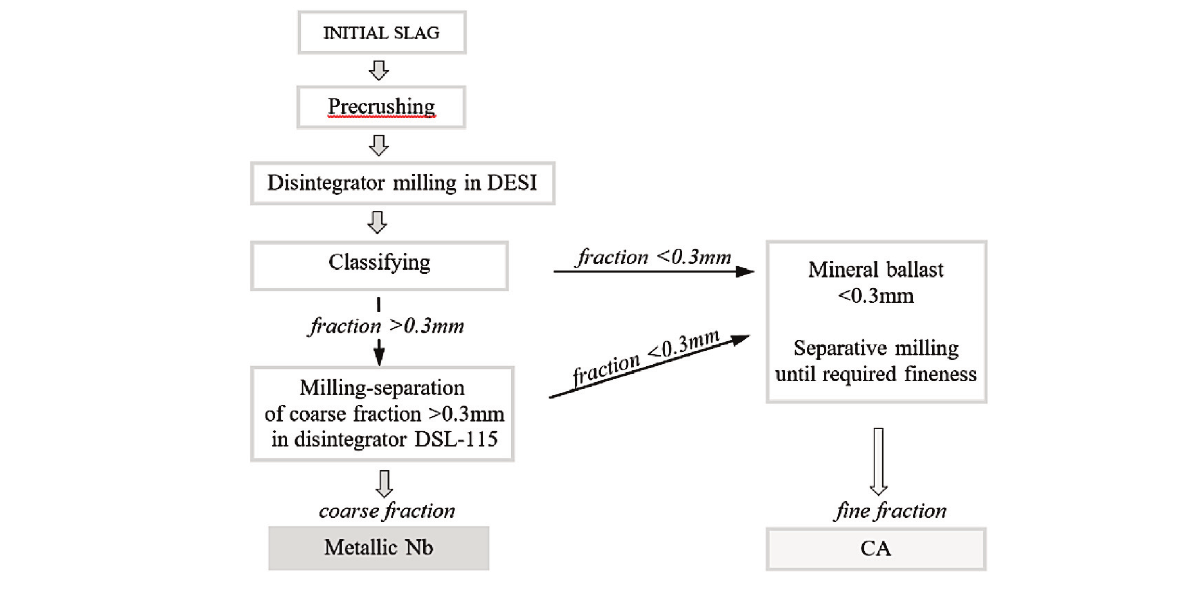
Fig. 1. Proposed scheme of milling of niobium slag and sep aration of metallic Nb.